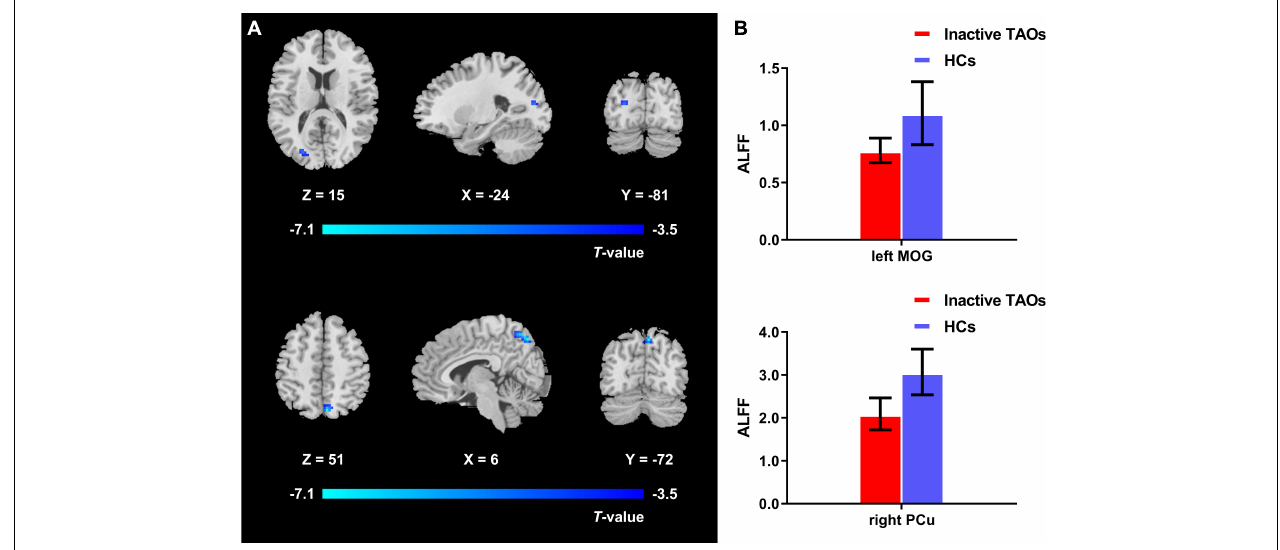
FIGURE 4 | (A) Brain regions with significant ALFF difference between the inactive TAO group and HCs. Compared with HCs, the inactive TAO group showed significantly decreased ALFF values in the left middle occipital gyrus, superior occipital gyrus, cuneus, and bilateral precuneus (voxel P < 0.001, cluster P < 0.05, cluster-level FWE corrected, cluster size ≥ 34 voxels). Cold color denotes relatively lower ALFF values in the inactive TAO group, and the color bar indicates the T value from the two-sample t -test between the inactive TAO group and HCs. (B) The bar plot demonstrates the ALFF difference of the significant brain regions in the inactive TAO group and HCs. The ALFF values used were the mean ALFF values extracted by using an ROI defined as a sphere centered at the peak voxel with a 6-mm radius. ALFF, amplitude of low frequency fluctuation; TAO, thyroid-associated ophthalmopathy; HCs, healthy controls; FWE, familywise error; ROI, region